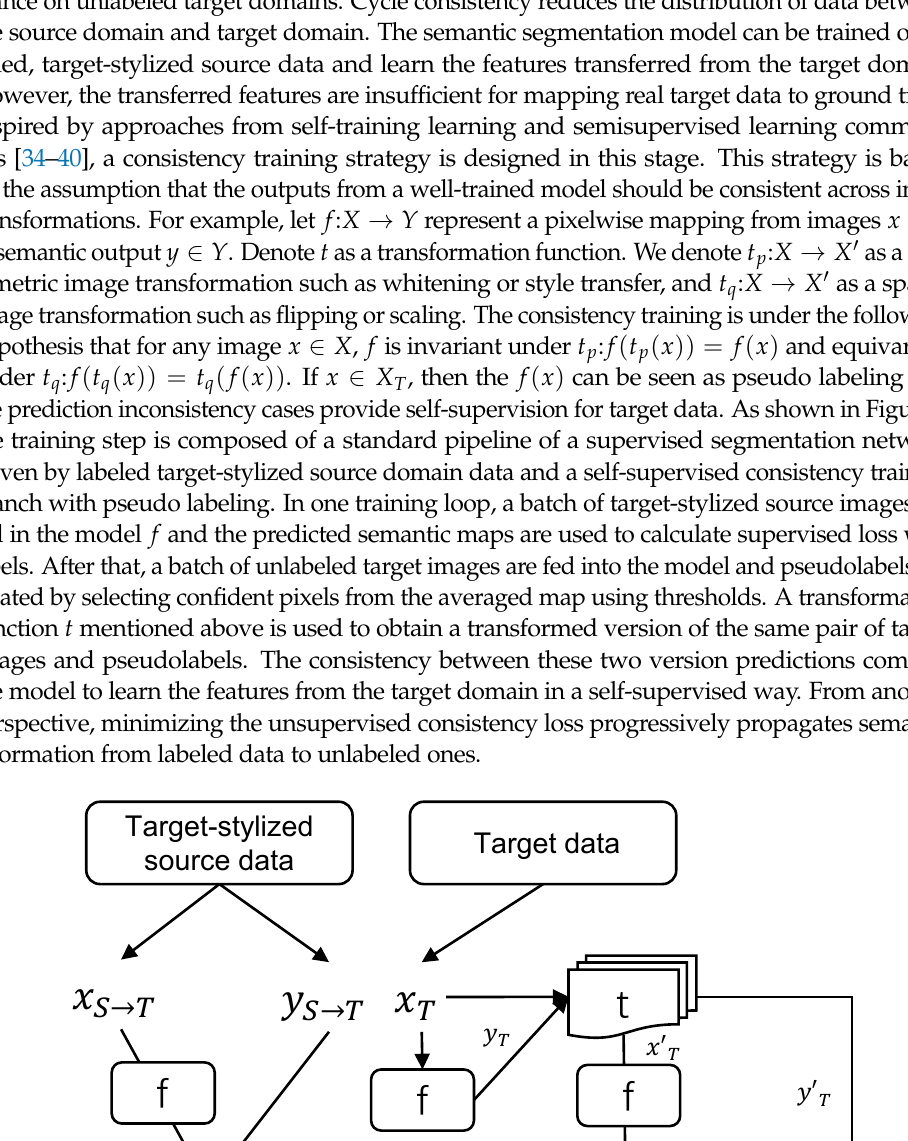
and y (cid:48) are the transformed T T are the semantic outputs of the f T